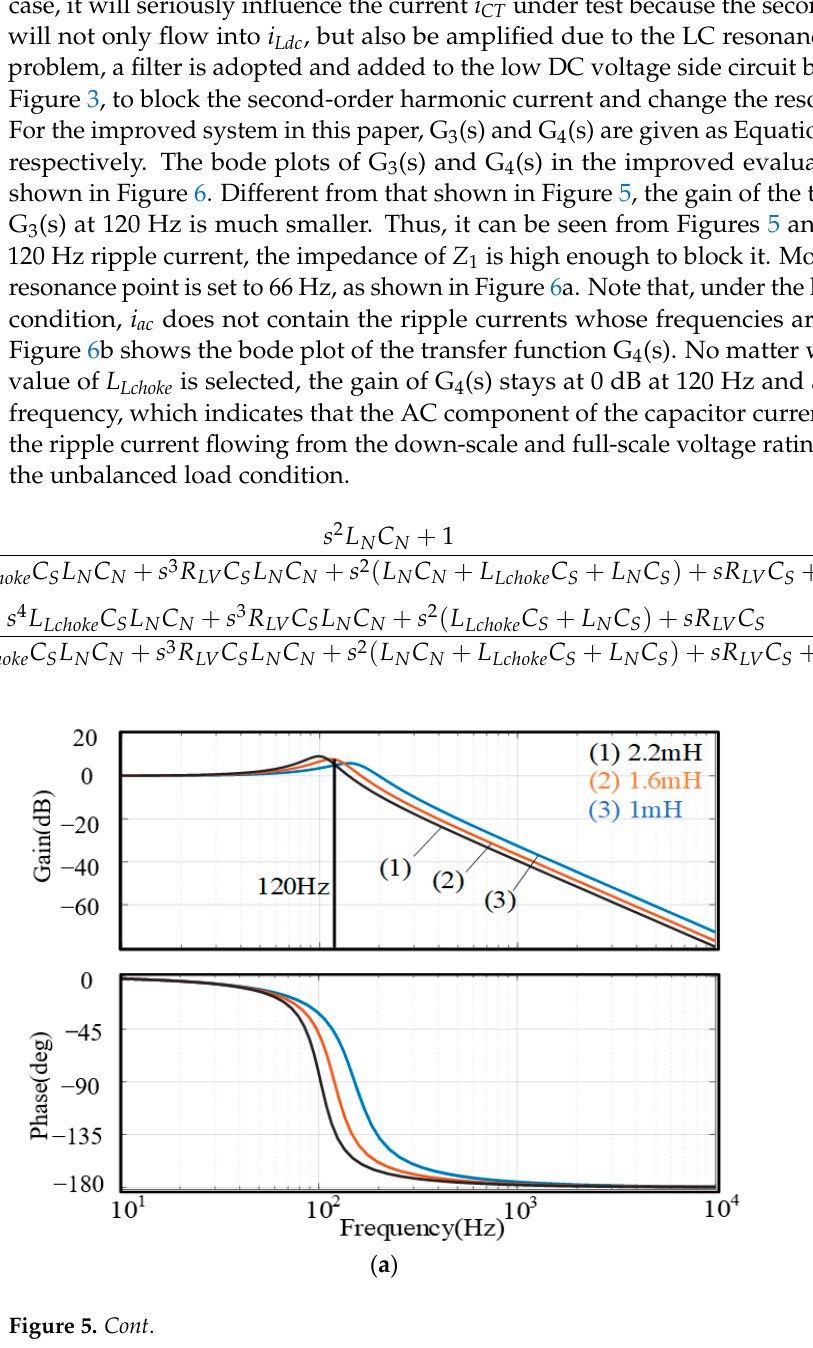
( b ) Figure 5. Bode plot of the transfer function in evaluation system proposed in [11]. ( a ) G 3 (s). ( b ) G 4 (s). ( a )